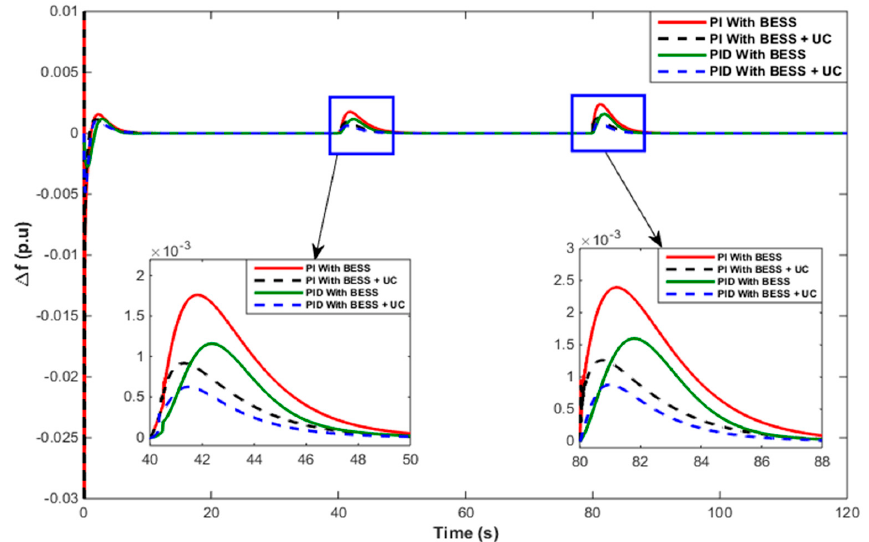
Figure 12. Comparative performances of the frequency responses of BESS (case 1) and BESS + UC (case 2) with the FPA-optimized PI and PID controllers employed in a hybrid response model.